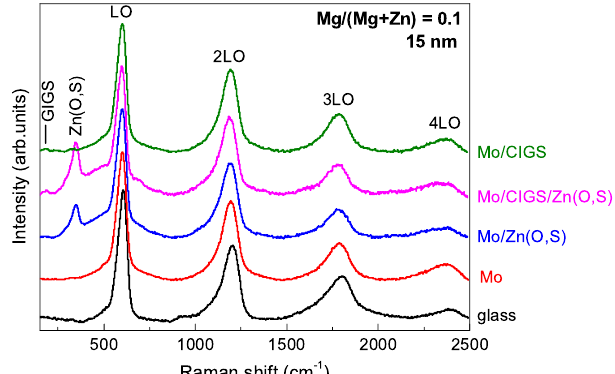
Figure 2. Raman scattering spectra (normalized to the intensity of the main LO peak) of ZnMgO layers grown with a relative Mg/(Mg + Zn) content of 10% and a thickness of 15 nm on the different kinds of substrates.